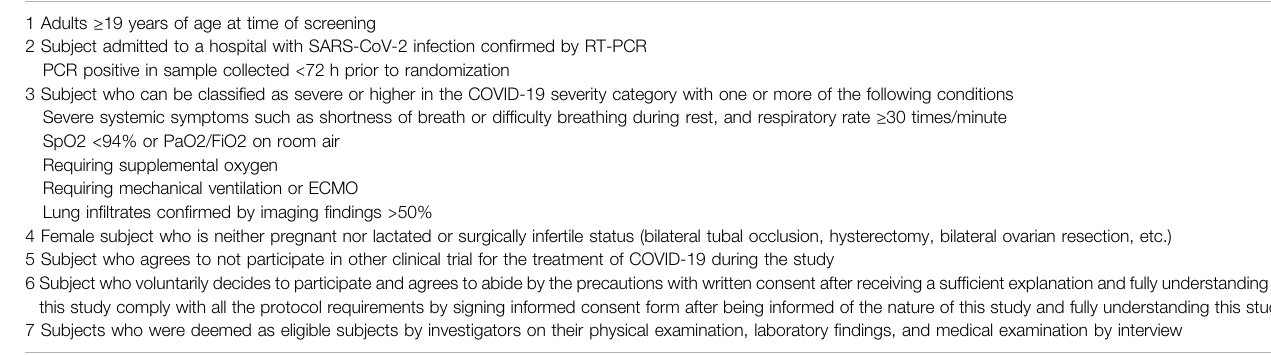
TABLE 3 | Examples of inclusion criteria for the study design of an anti-in fl ammatory agent for COVID-19. 1 Adults ≥ 19 years of age at time of screening 2 Subject admitted to a hospital with SARS-CoV-2 infection con fi rmed by RT-PCR PCR positive in sample collected < 72 h prior to randomization 3 Subject who can be classi fi ed as severe or higher in the COVID-19 severity category with one or more of the following conditions Severe systemic symptoms such as shortness of breath or dif fi culty breathing during rest, and respiratory rate ≥ 30 times/minute SpO2 < 94% or PaO2/FiO2 on room air Requiring supplemental oxygen Requiring mechanical ventilation or ECMO